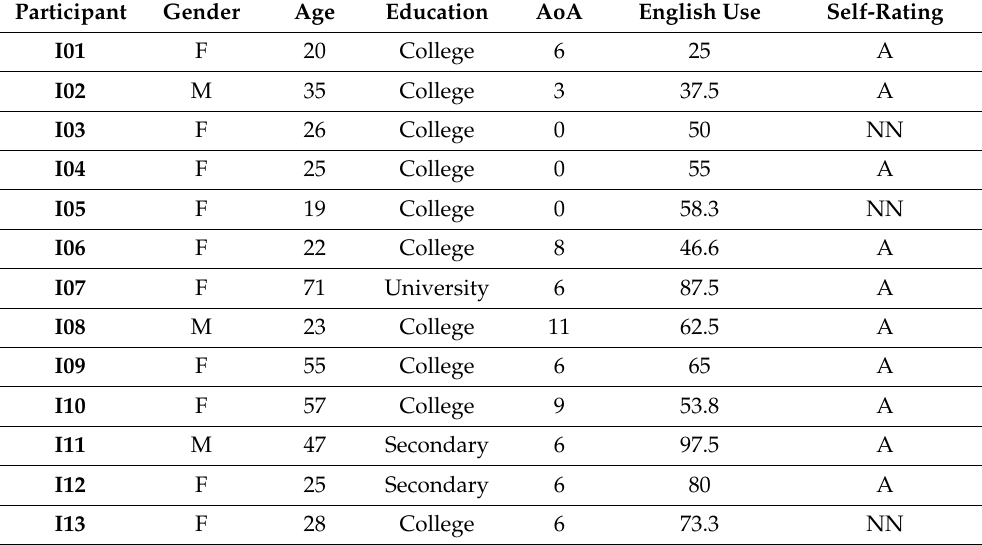
Table 1. Participants’ profiles. Notes: AoA = Age of onset of Acquisition of English. English Use